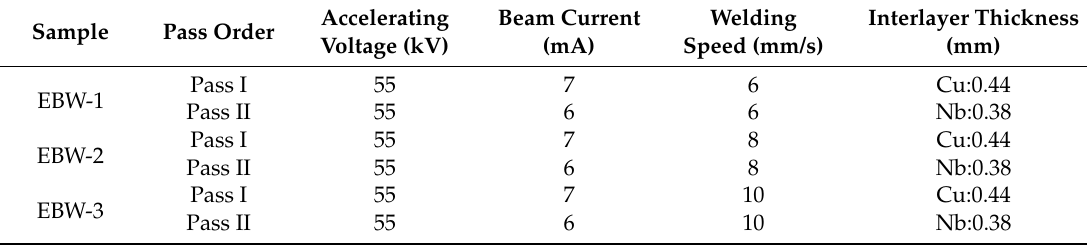
Figure 1. Schematic experimental conditions of the dual-pass welding procedure. Table 3. Welding parameters used in dual-pass